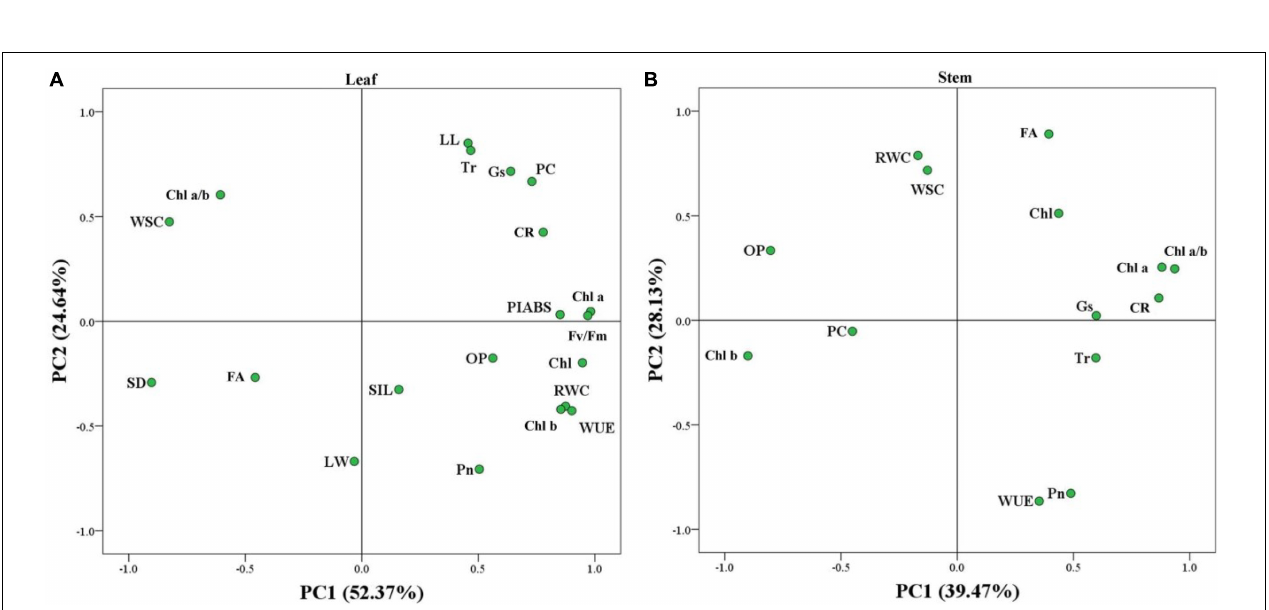
FIGURE 8 | Principal component analysis of the stress index (SI) in (A) leaf and (B) stem of common and hybrid bermudagrasses.